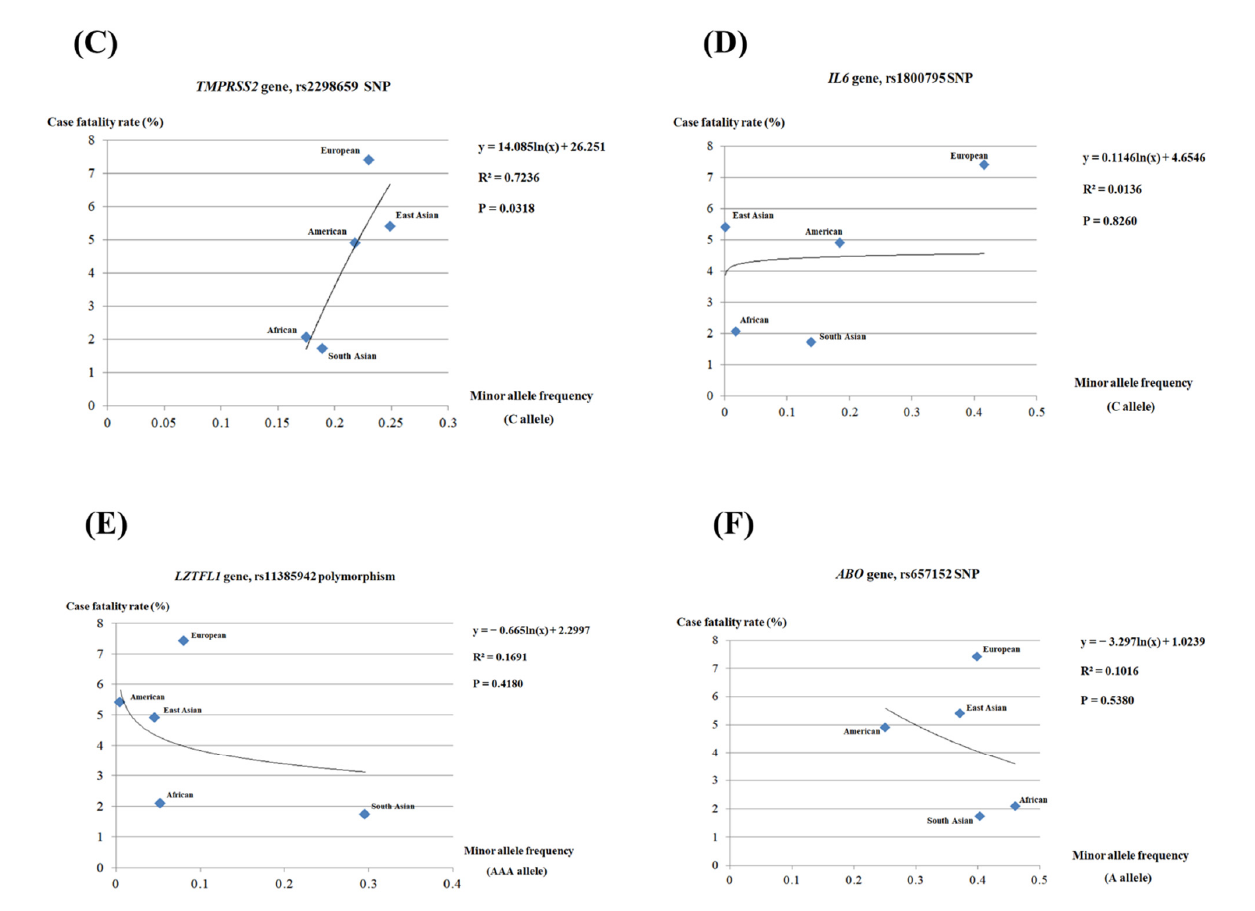
Figure 1. ( A ) Log-linear regression relationships between the case fatality rate of coronavirus disease-2019 (COVID-19) and minor allele frequency (MAF) of the rs6598045 single nucleotide polymorphism (SNP) of the interferon-induced transmembrane protein 3 ( IFITM3) gene. ( B ) Log-linear regression relationships between the case fatality rate of COVID-19 and MAF of the rs2074192 SNP of the angiotensin I converting enzyme 2 ( ACE2 ) gene. ( C ) Log-linear regression relationships between the case fatality rate of COVID-19 and MAF of the rs2298659 SNP of the transmembrane protease serine 2 ( TMPRSS2 ) gene. ( D ) Log-linear regression relationships between the case fatality rate of COVID-19 and MAF of the rs1800795 SNP of the interleukin 6 ( IL6 ) gene. ( E ) Log-linear regression relationships between the case fatality rate of COVID-19 and MAF of the rs11385942 insertion/deletion polymorphism of the leucine zipper transcription factor-like protein 1 ( LZTFL1 ) gene. ( F ) Log-linear regression relationships between the case fatality rate of COVID-19 and MAF of the rs657152 SNP of the ABO